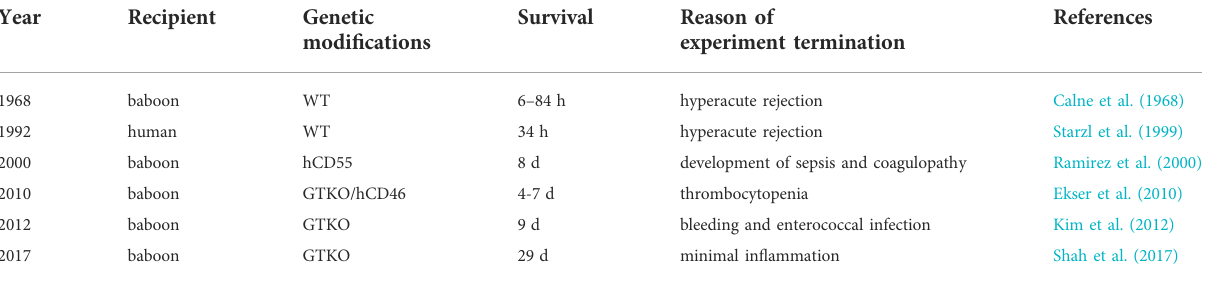
TABLE 2 Progress in transgenic porcine liver